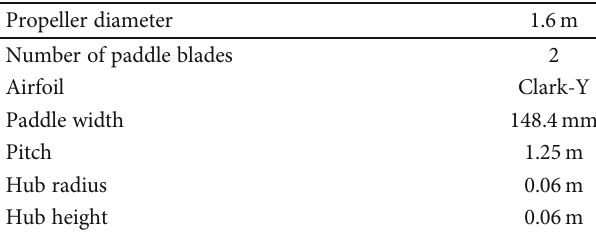
Figure 10: Total acoustic pressure level of the measurement point (A). Table 3: New propeller